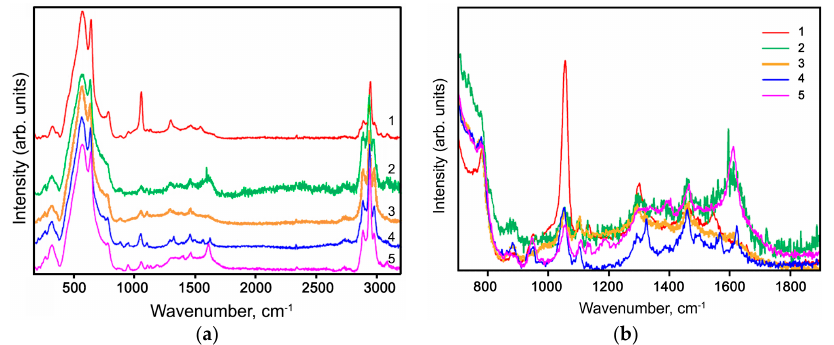
Figure 5. Room-temperature Raman spectra of hybrid powder samples (1) CuPc/SnO 2 , (2) CuBzPh/SnO 2 , (3) CuChPh/SnO 2 , (4) CuBiPy/SnO 2 , (5) CuAzaCr/SnO 2 in the spectral range of ( a ) 172–3200 cm − 1 ; ( b ) 700–1900 cm − 1 .